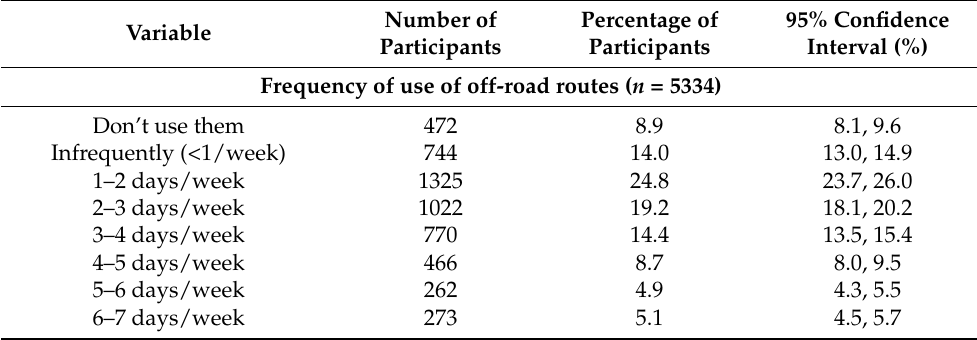
Table 2. A summary of UK equestrians’ ( n = 5335) activity around using off-road routes and roads to exercise their horses, ponies, donkeys and